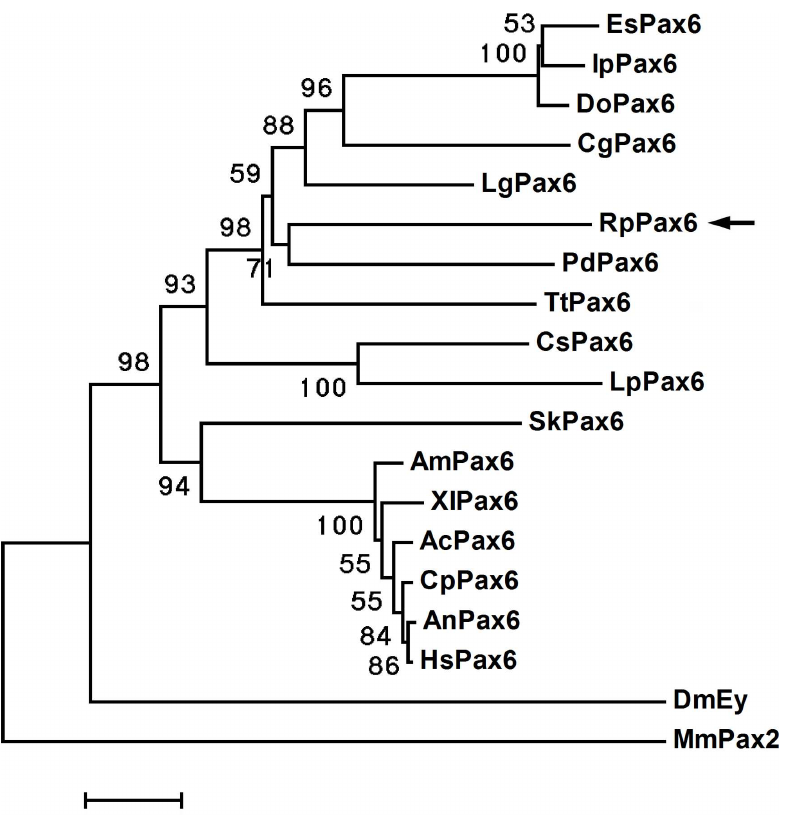
Fig 2. Phylogenetic position of RpPax6 . A neighbor-joiningtree basedon a comparisonof the deduced amino acid sequencesof full-lengthclones of Pax6 with mouse Pax2 includedas outgroup.Numbers at nodes indicatethe levels of bootstrap support based on data for 1,000 replicates; only values greater than 50% are shown. Bar 5% estimated sequenceddivergence.